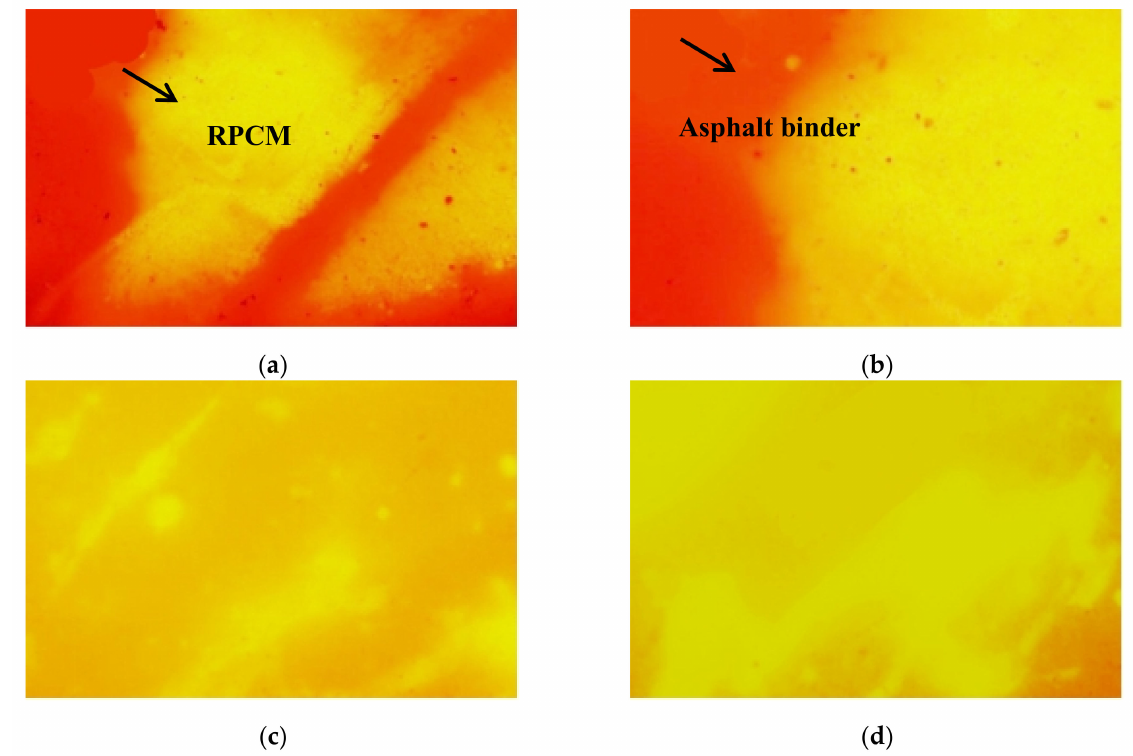
Figure 9. Fluorescence micrograph of 0.35% RPCM-modified HMAB under different evolution times: ( a ) 0 h, ( b ) 1 h, ( c ) 2 h, and ( d ) 3